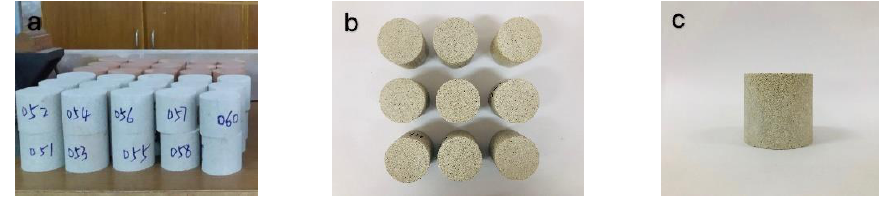
Figure 2. White sandstone specimens ( a – c ). Table 1. Chemical solution.